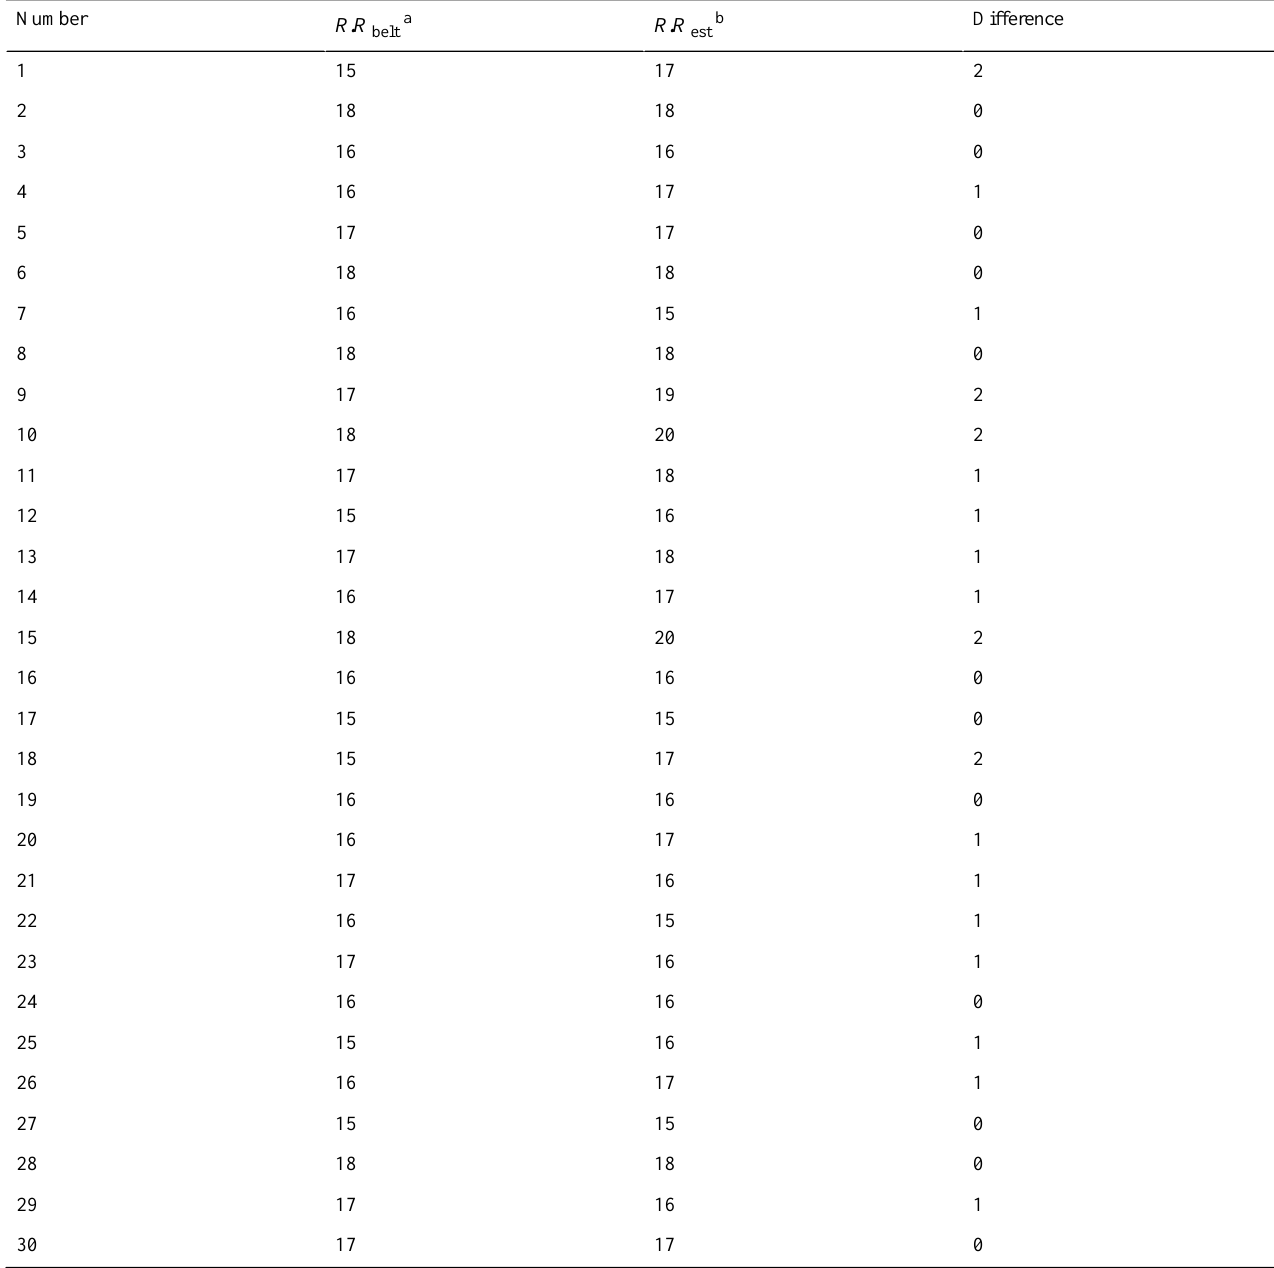
Table 3. Results of respiration rate